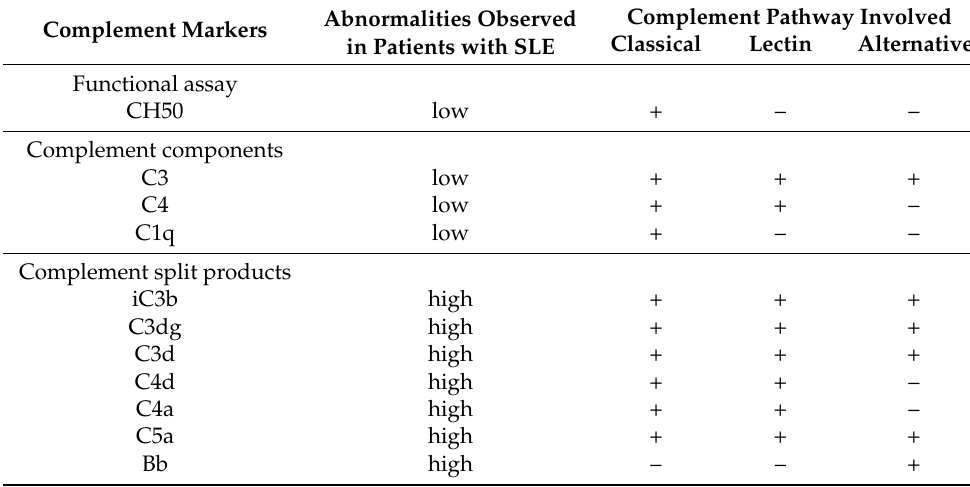
Table 1. Complement